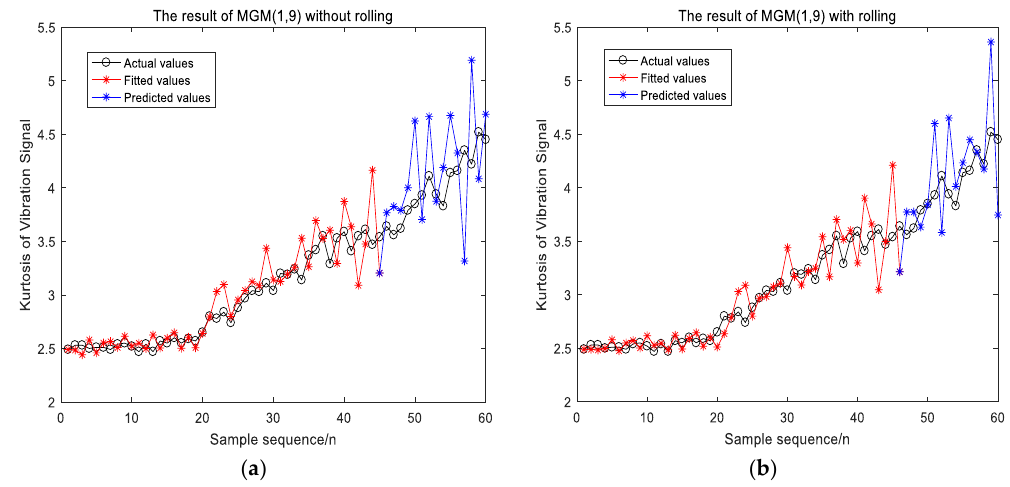
Figure 4. The result of MGM (1,9) and IMGM (1,9) for vibration signal. ( a ) The result of MGM (1,9); ( b ) the result of IMGM (1,9).